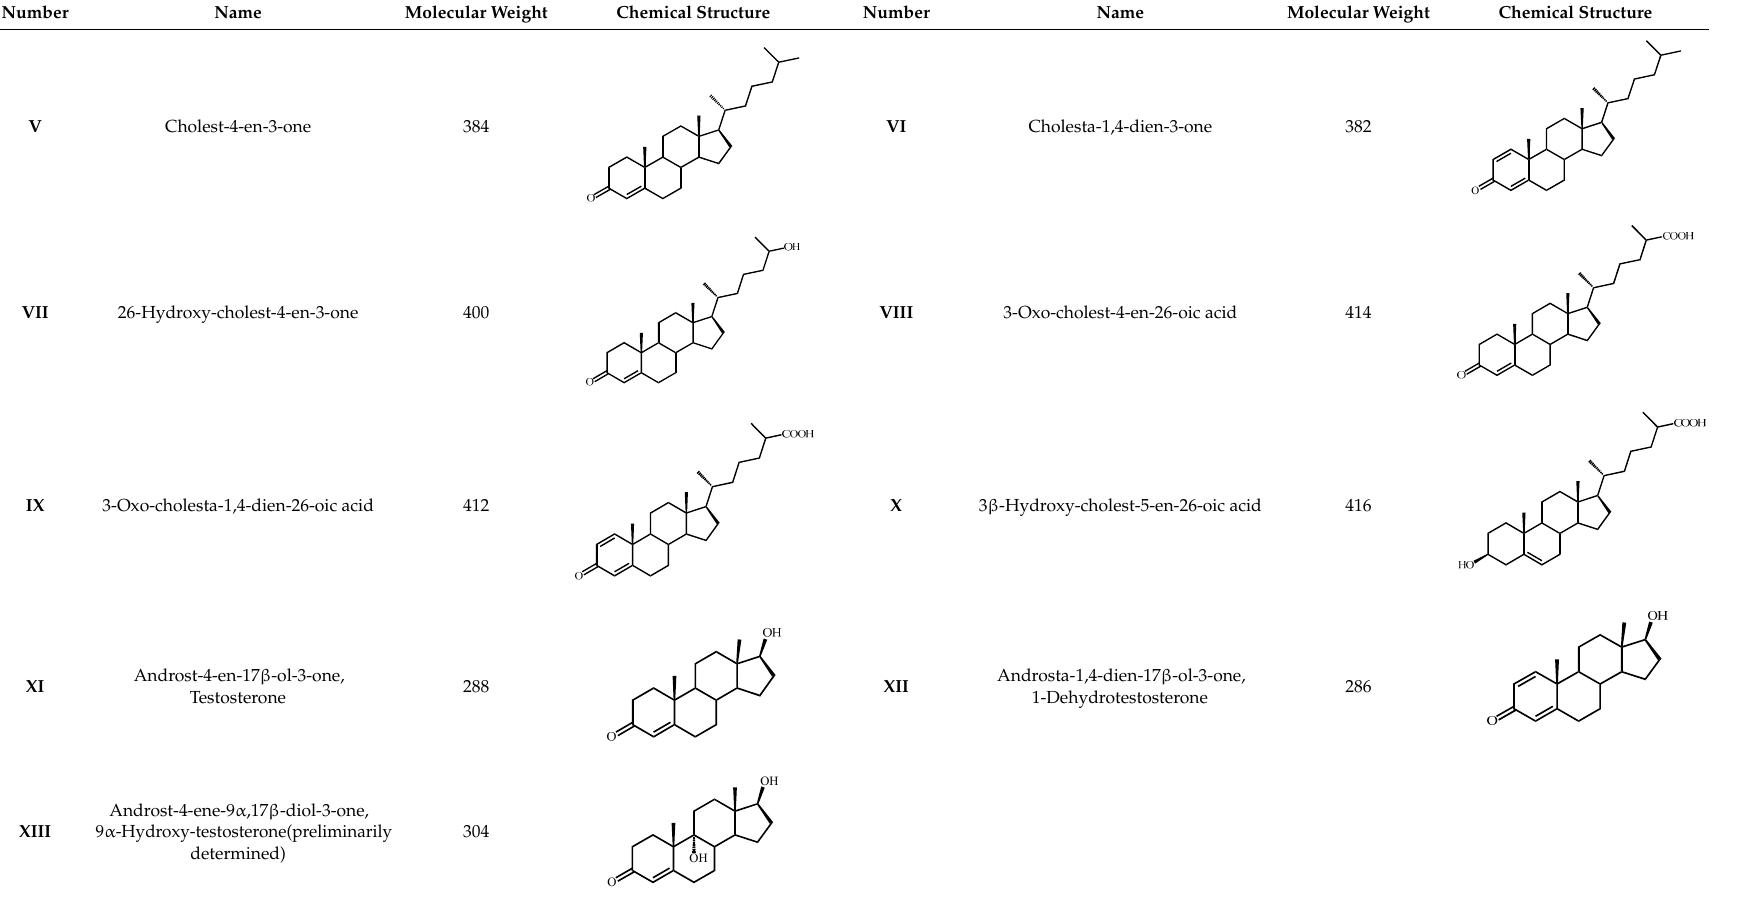
Table 1. Steroid intermediates detected during cholesterol bioconversion by N. simplex VKM Ac-2033D.